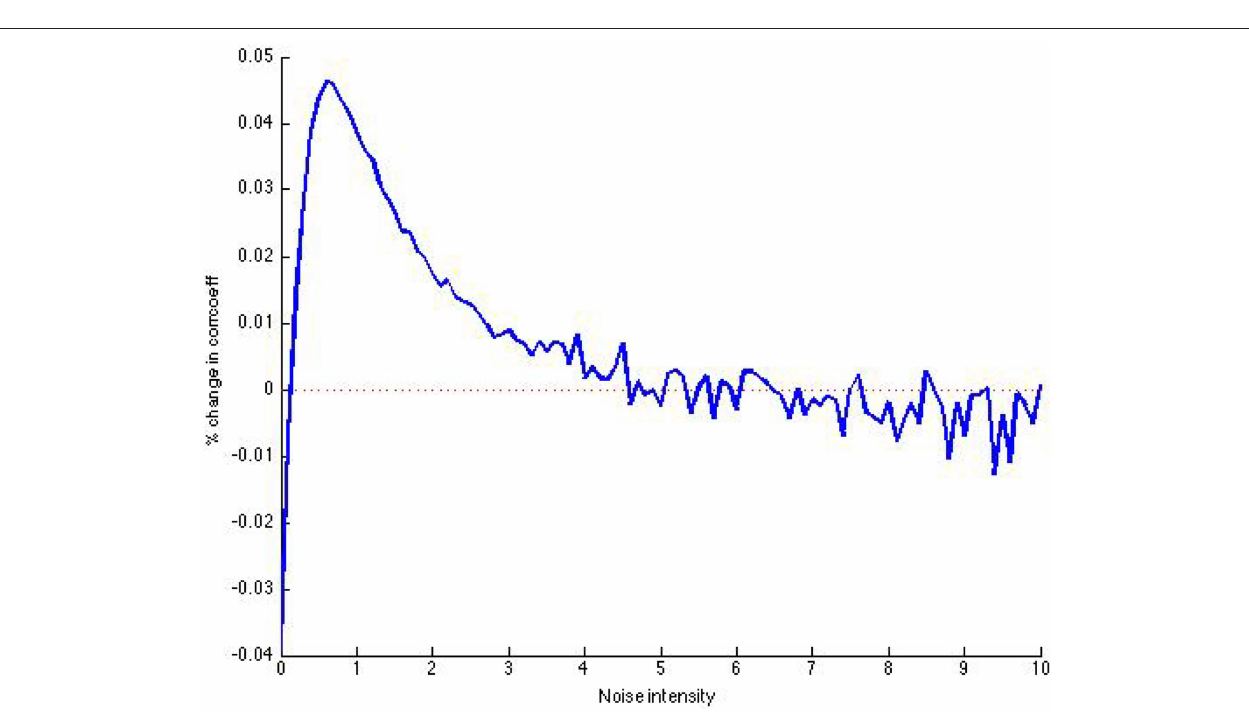
FIGURE 6 | Close-up of post-SSR increase in correlation coefficient using N = 10,000 threshold units, over 1000 time